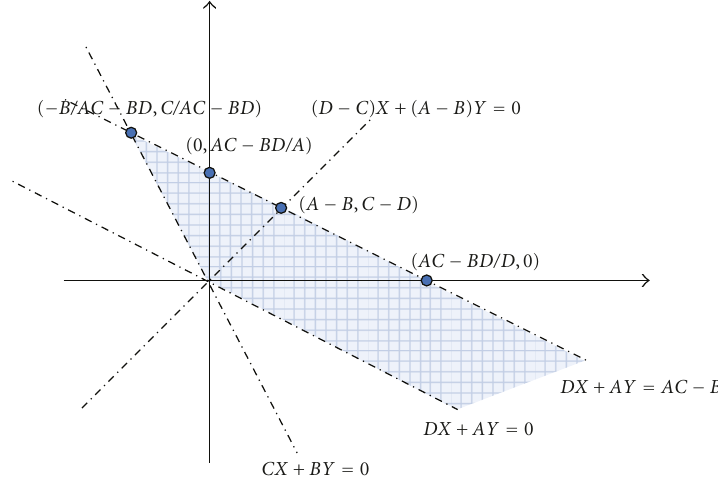
Figure 2: Points ( X , Y ) that satisfy the restrictions when AC − BD >